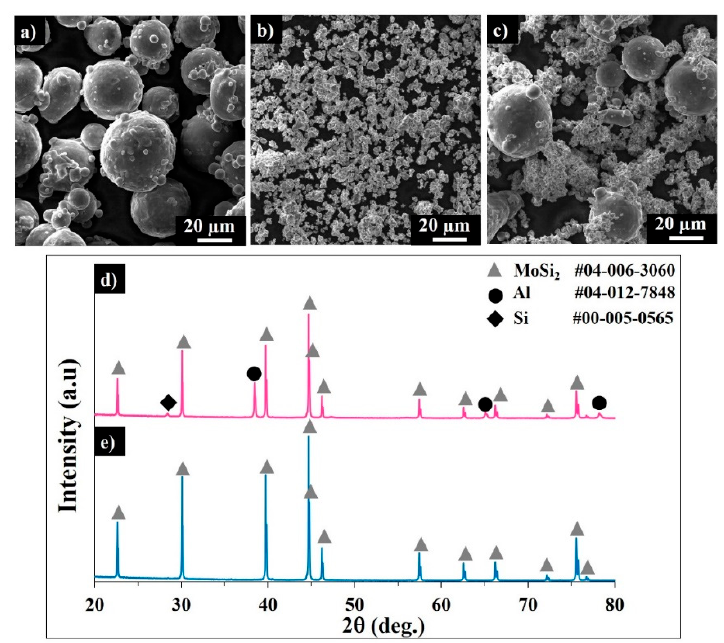
Figure 1. SEM images of the AlSi10Mg alloy ( a ) MoSi 2 and ( b ) MoSi 2 -30 wt.% AlSi10Mg powder mixture ( c ). Corresponding XRD patterns of the MoSi 2 -30 wt.% AlSi10Mg ( d ) and MoSi 2 ( e ) powders. Table 3. Size distributions of the AlSi10Mg, MoSi 2 , and MoSi 2 -30 wt.% AlSi10Mg powders. Composition